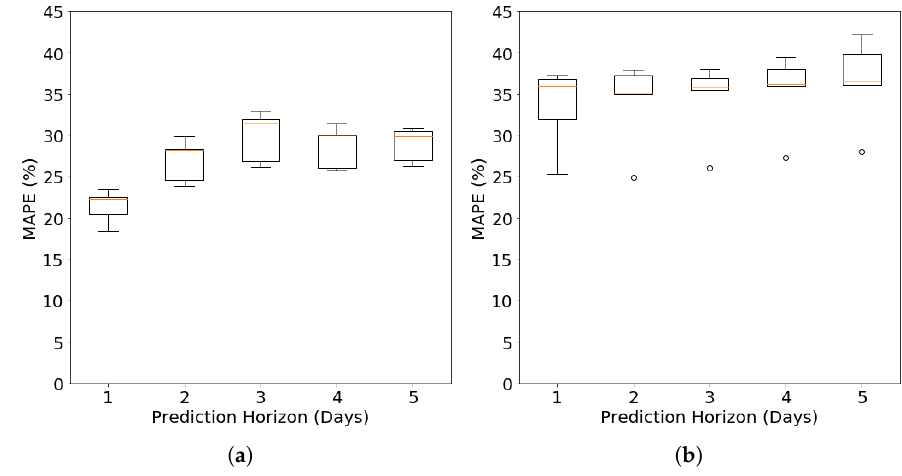
Figure 13. MAPE for forecasting the Y2E2 lighting load using our long-term load forecasting kernel (Section 3.2.2) and a combination of a linear and matern kernel. ( a ) Our long Term Load Forecasting Kernel in Section 3.2.2; ( b ) Combination of Matern and linear kernels for Long Term